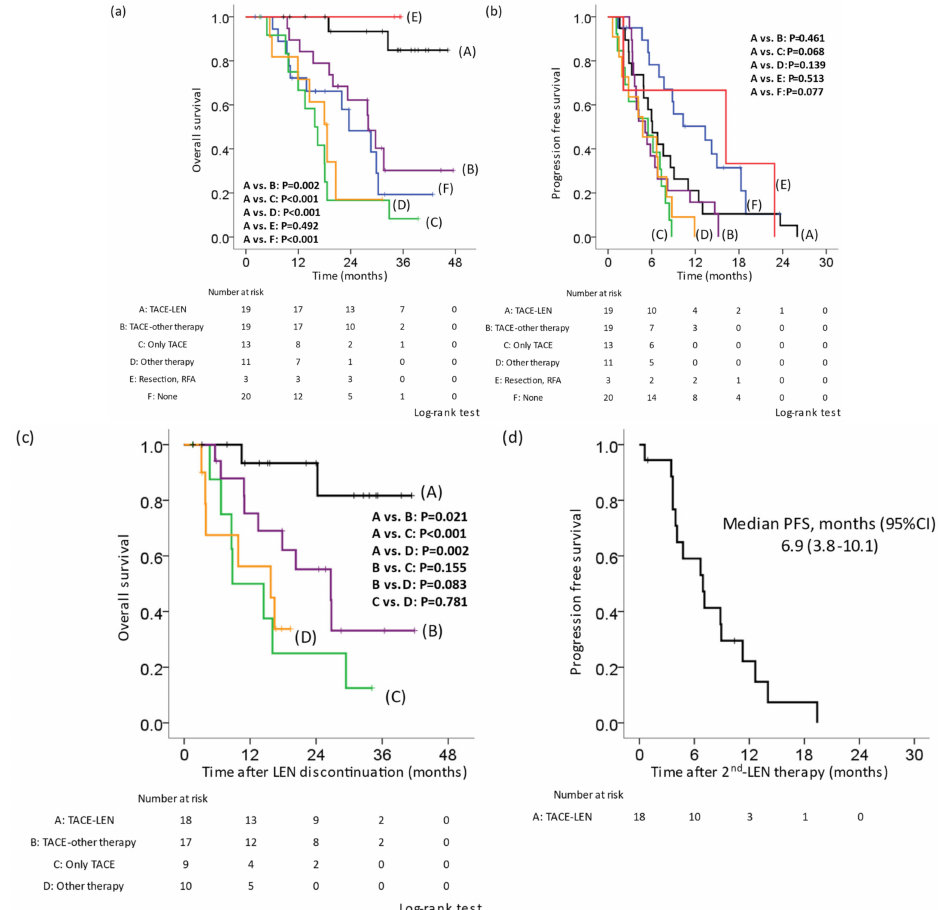
Figure 2. Kaplan–Meier curve of the overall survival and progression-free survival according to post-treatment in cases in which lenvatinib therapy was discontinued. Cases in which lenvatinib (LEN) was discontinued were divided into six groups. A: TACE-LEN, LEN was re-administered after TACE. B: TACE-other therapy, sorafenib, regorafenib, ramucirumab, cabozantinib, and atezolizumab + bevacizumab were introduced after TACE. C: Only TACE. D: Other therapy, only drug therapy without TACE. E: RFA or resection. F: No therapy. ( a ) OS from the initiation of LEN. The OS in group A was significantly better than that in groups B, C, D, or F. ( b ) The PFS from the first initiation of LEN. There was no significant difference between group A and groups B, C, D, or F. ( c ) OS from the first discontinuation of LEN in patients for whom LEN was administered in the first line and who underwent post-treatment. The OS in group A was significantly better than that in groups B, C, or D. ( d ) The PFS from the second initiation of LEN. LEN, lenvatinib; TACE, transcatheter arterial chemoembolization; OS, overall survival; PFS, progression-free